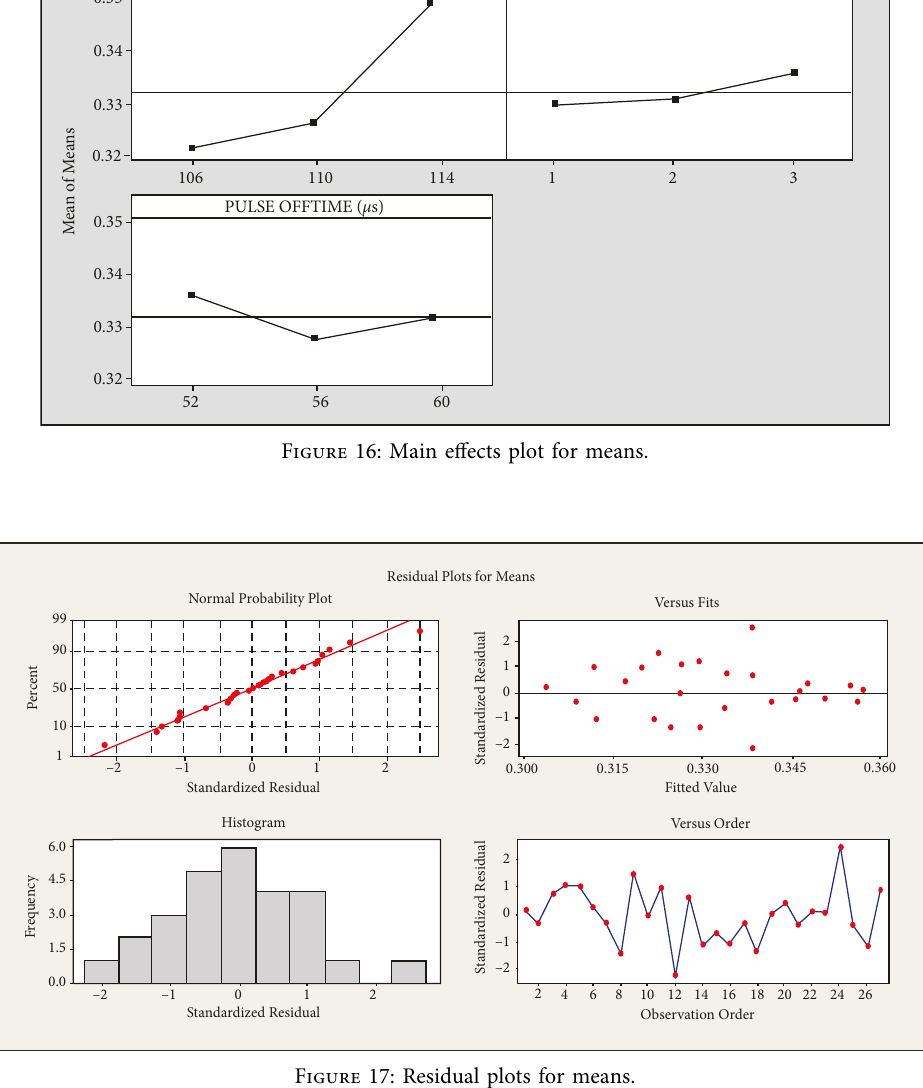
3.4.4. Taguchi Graphical Outputs for SR. Figure 21 shows the main effect plot for means. The effect of three control factors (viz. PT , PT and WF) on the surface ON OFF roughness. The SR increases with the gradual increase in the pulse on-time. The effect of pulse on time (Ton) on surface roughness is depicted in Table 11. As seen from the